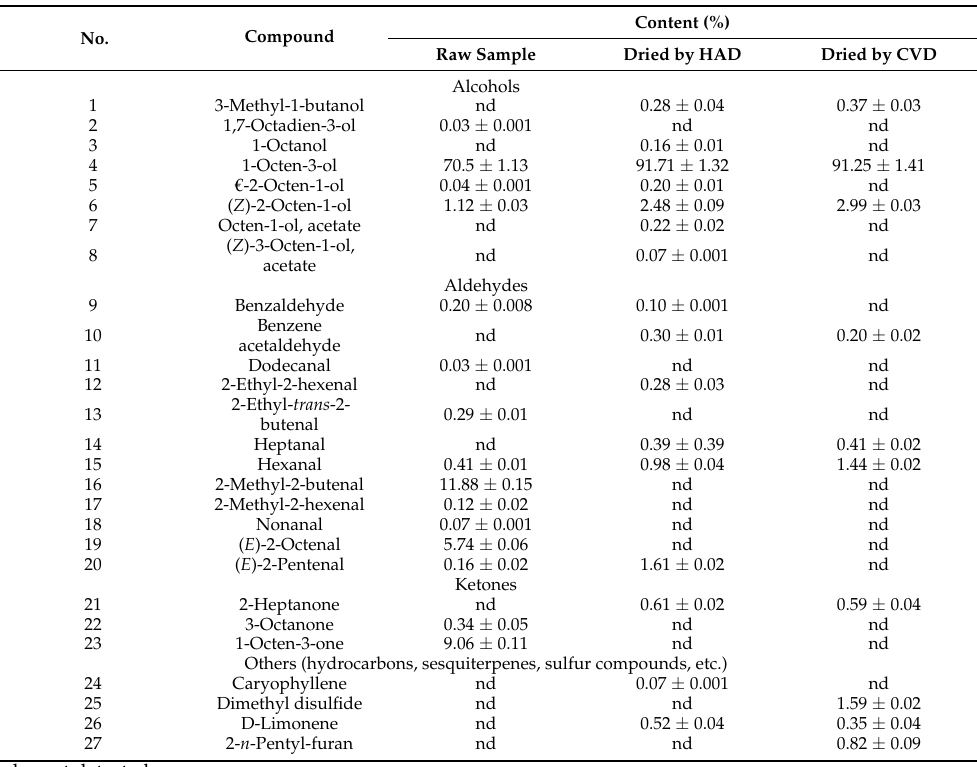
Table 3. Mean relative peak areas (expressed as % from total peak areas) of aroma compounds from raw and dried B. edulis mushrooms as determined by HS-ITEX/GC–MS; data values are mean ± SD. Content (%) No. Compound Raw Sample Dried by HAD Dried by